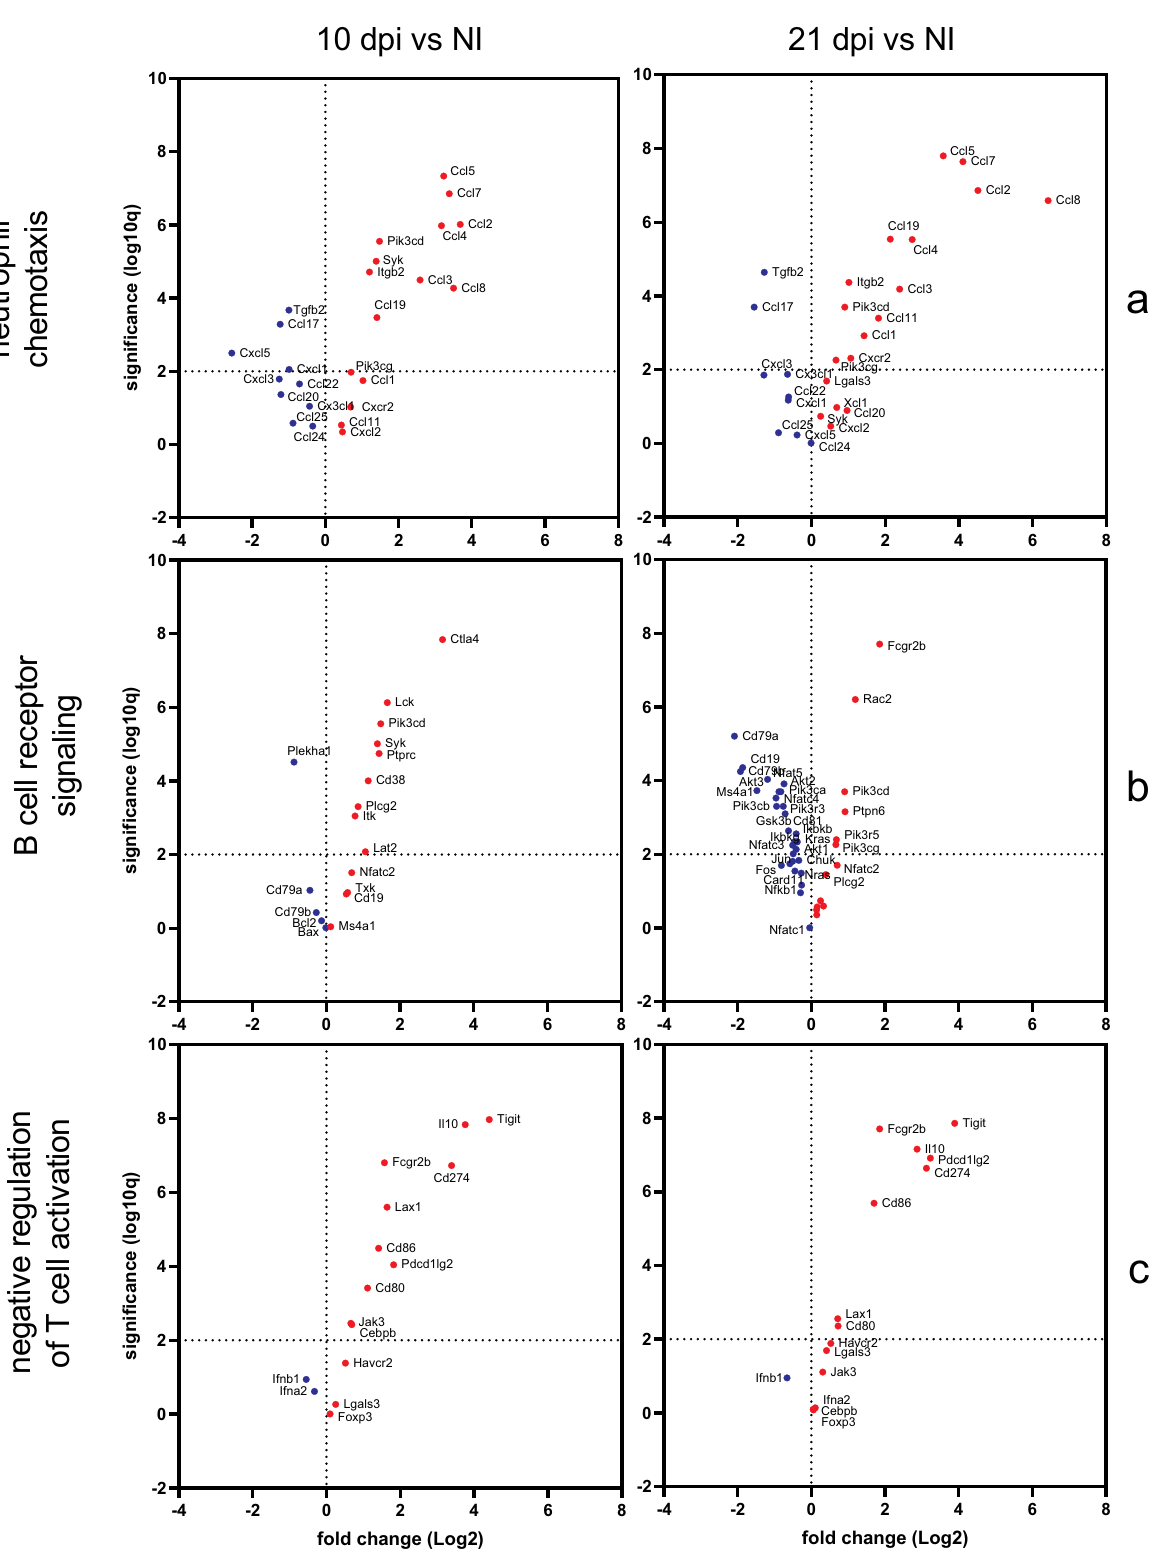
Fig. 8 | Gene ontology analysis of T. b. brucei infected lung tissue. Volcano plot of DE genes involved in the GO terms: a neutrophil chemotaxis, b B cell receptor signalling pathway and c negative regulation of T cell